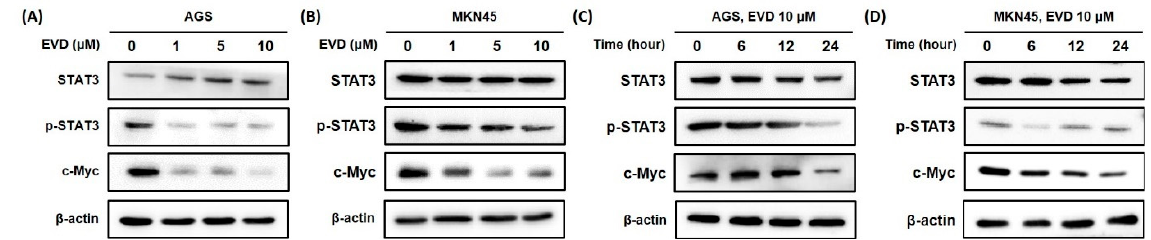
Figure 6. Evodiamine inhibits STAT3 activation and cMyc expression in AGS and MKN45 cells. Indicated dose of evodiamine (0, 1, 5, and 10 μ M) for 24 h were applied to ( A ) AGS and ( B ) MKN45 cells. A total of 10 μ M evodiamine for the indicated time periods (0, 6, 12, 24 h) were treated in ( C ) AGS and ( D ) MKN45 cells. The cell lysates were subjected to Western blot to evaluate the levels of STAT3, p-STAT3, and c-Myc. β -actin was used as an internal control. EVD, evodiamine.